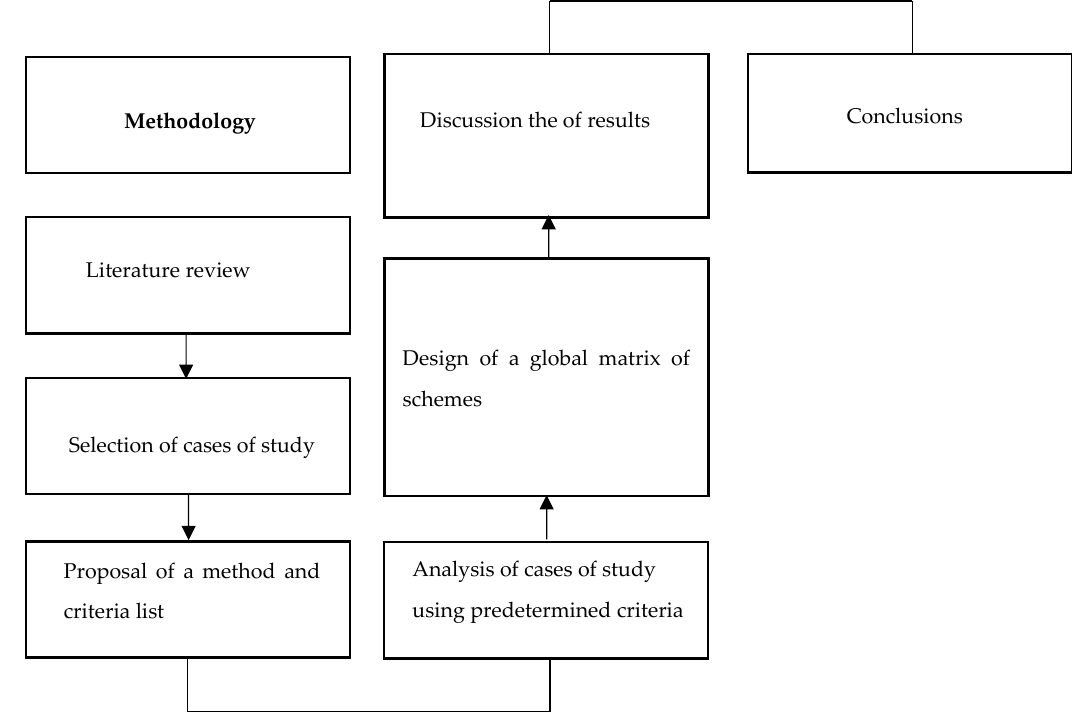
Figure 5. Conceptual graph summarising the research methodology.